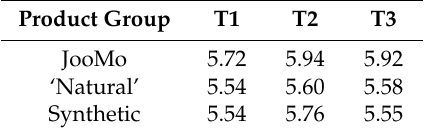
Table A3. Comparison of the pH of the participants’ skin based on the pH-meter measurement before product use (=T1), after 2 weeks of product use (=T2) and after 4 weeks of product use